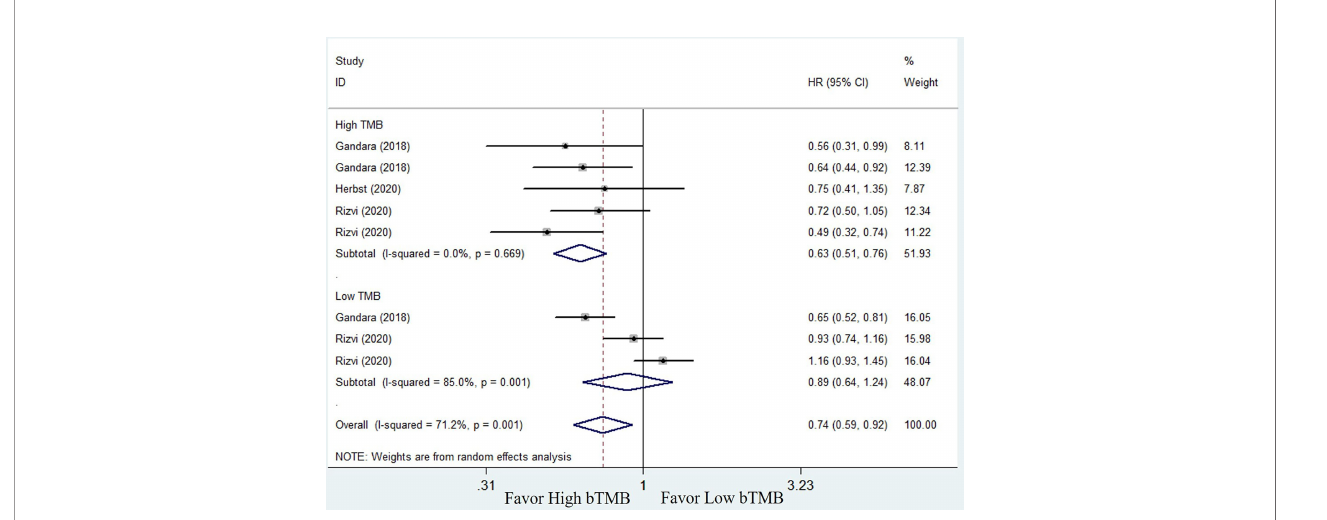
FIGURE 4 | Forest plot of ef fi cacy comparison of ICIs to chemotherapy for overall survival (OS) and subgroup